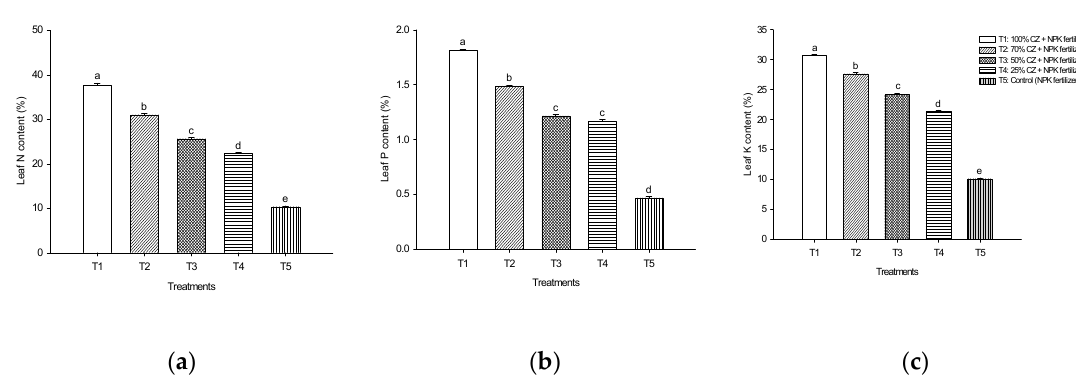
Figure 3. Leaf nitrogen ( a ); phosphorus ( b ); and potassium ( c ) contents during flowering of papaya cv. Sekaki cultivation on a tropical peat soil treated with different amounts of CZ and NPK fertilizer. Error bar represents standard error of the mean. Means with different letters indicate significant difference between treatments by Tukey’s test at p ≤ 0.05. CZ: clinoptilolite zeolite; T1: 100% CZ + NPK fertilizer; T2: 70% CZ + NPK fertilizer; T3: 50% CZ + NPK fertilizer; T4: 25% CZ + NPK fertilizer; T5: Control (NPK fertilizer only). Table 6. Vegetative growth of papaya cv. Sekaki cultivation on tropical peat soil treated with di ff erent amounts of CZ and NPK fertilizer.